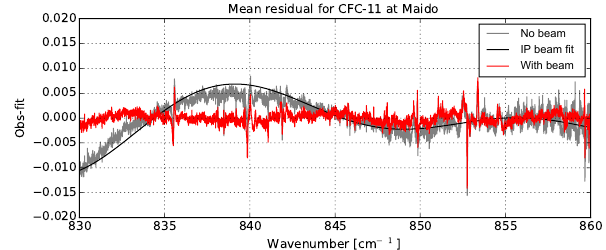
Figure 2. The mean residual transmittance (observed–calculated) of the CFC-11 retrievals with and without beam parameters at Maïdo. The IP beam fit line is used as a priori IP beam